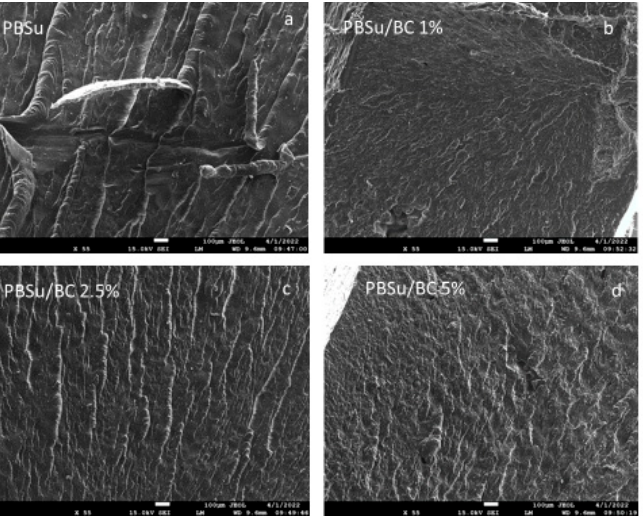
Figure 13. SEM micrographs of the impact fracture surfaces of PBSu/BC composite in low magnifica- tion, for samples indicated on the figure.